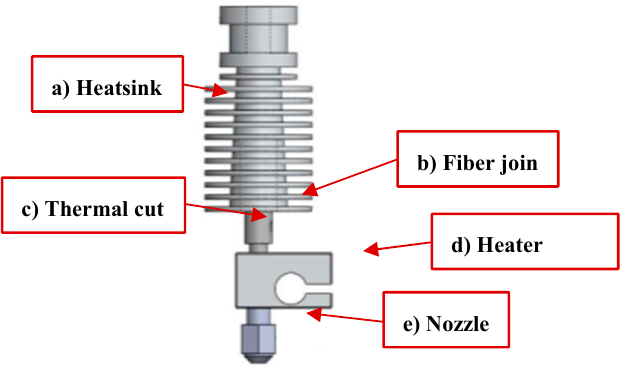
Figure 3. Deposition nozzle system; ( a ) heatsink zone; ( b ) fiber join hole; ( c ) heat break (thermal cut); ( d ); heater block; ( e ) extrusion nozzle.